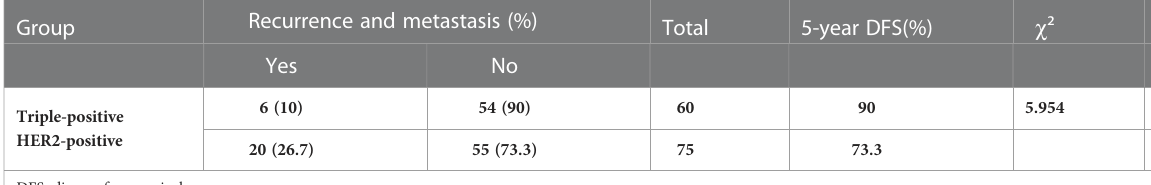
DFS, disease-free survival.